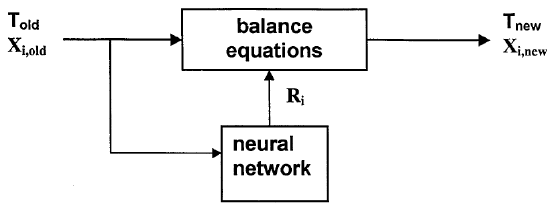
Figure 7. Schematic diagram of the hybrid model of chemical reactor [84]. Reprinted with permission from Elsevier.